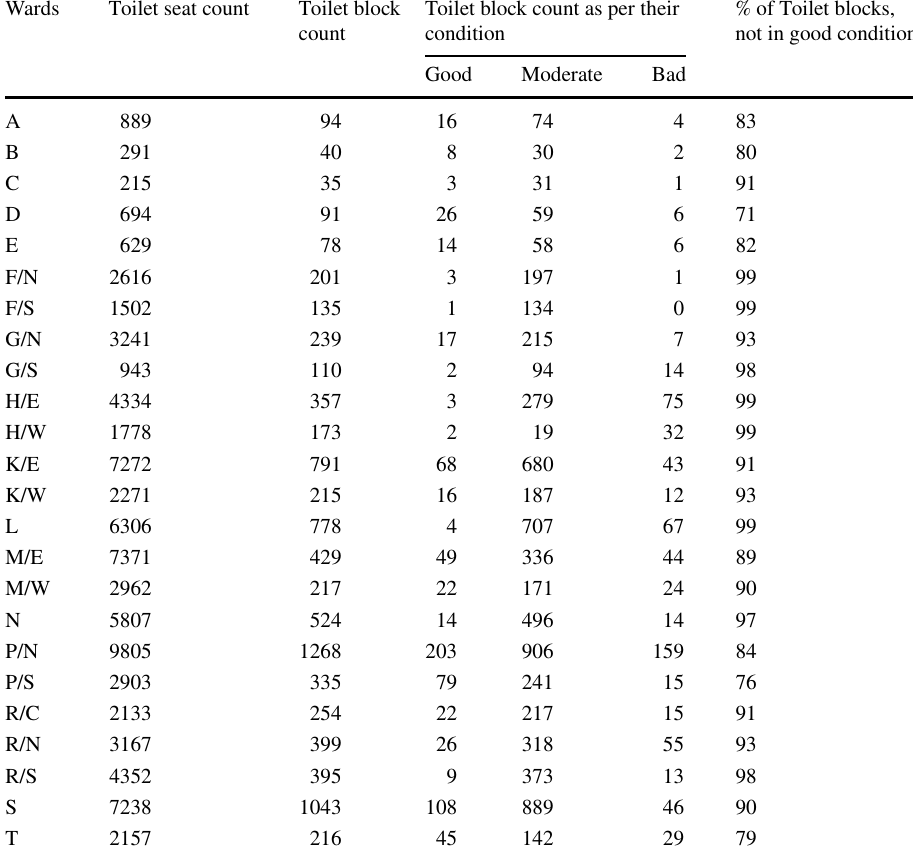
Wards Toilet seat